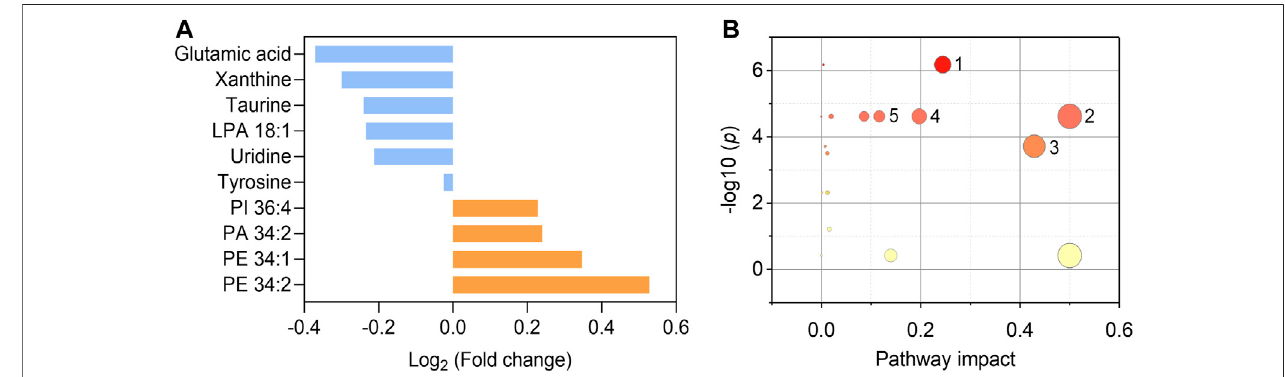
FIGURE5| Foldchangesofthetenbiomarkersandpotentialpathwaysalteration. (A) Foldchangesofsixdown-regulatedmetabolites(blue)andfourup-regulated phospholipids (orange) in asymptomatic COVID-19 patients compared with healthy controls. (B) Potential pathways differentially regulated in asymptomatic COVID-19 patients vs. healthy controls. The ten selected metabolites were tested to identify altered pathways. The color and size ofeach circle were correlated tothe p values and pathway impact values, respectively. A total of fi ve pathways were considered as altered ( p < 0.05, pathway impact > 0.1): (Zhou et al., 2020) Glycerophospholipid metabolism; (Wu et al., 2020) Glutamine and glutamate metabolism; (Huang C. et al., 2020) Taurine and hypotaurine metabolism; (Guan et al., 2020) Alanine, aspartate, and glutamate metabolism; (Chan et al., 2020) Arginine biosynthesis.